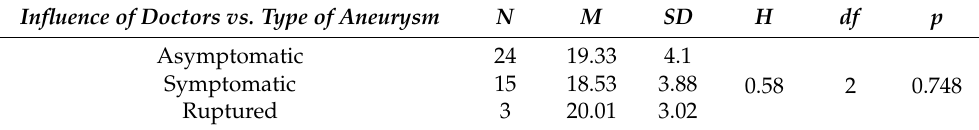
Table 7. Influence of doctors vs. type of aneurysm. Influence of Doctors vs. Type of Aneurysm N M SD H Asymptomatic